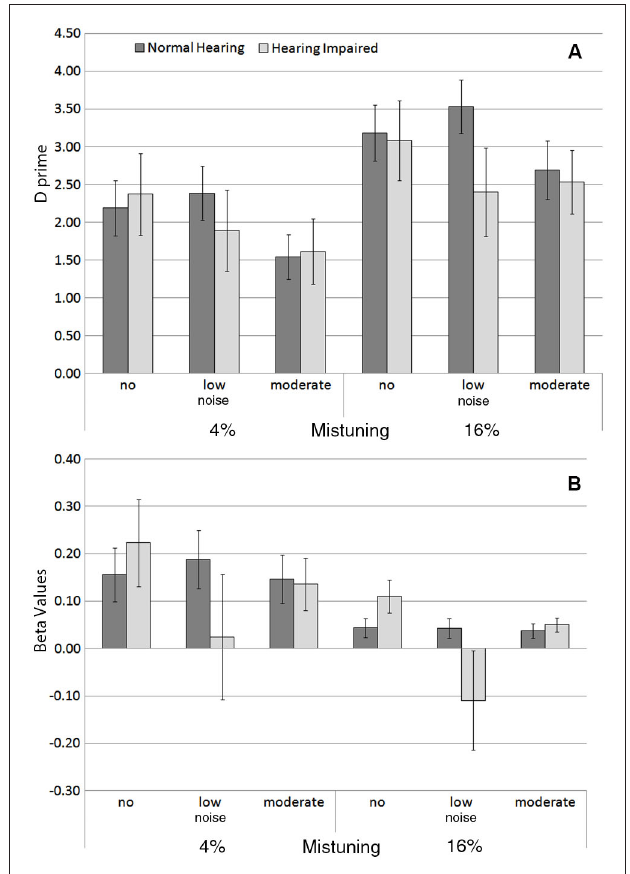
FIGURE 3 | (A) Group mean sensitivity ( d‘ ) and (B) response bias ( β ) for each background noise condition for the 4% and for the 16% mistuned harmonics in normal hearing and in hearing impaired older adults. The error bars indicate ± 1 standard error of the mean.